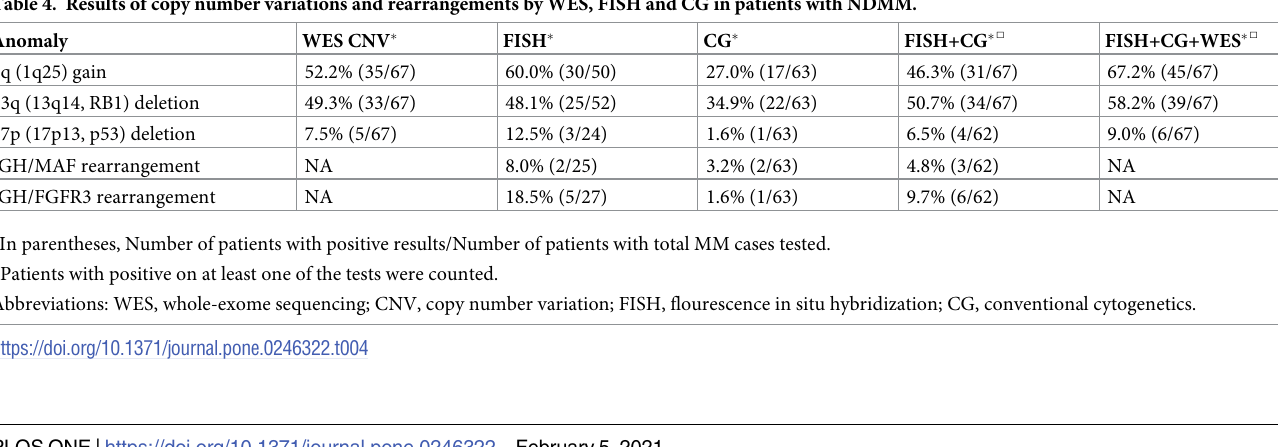
Table 4. Results of copy number variations and rearrangements by WES, FISH and CG in patients with NDMM. Anomaly